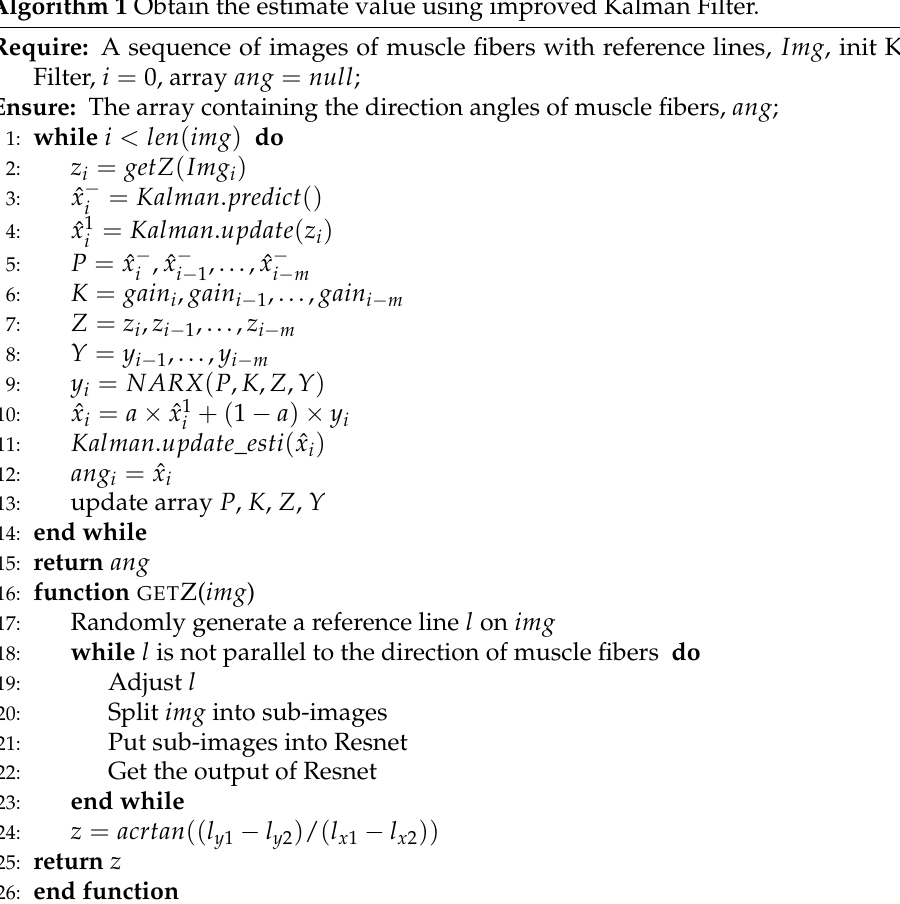
Algorithm 1 Obtain the estimate value using improved Kalman